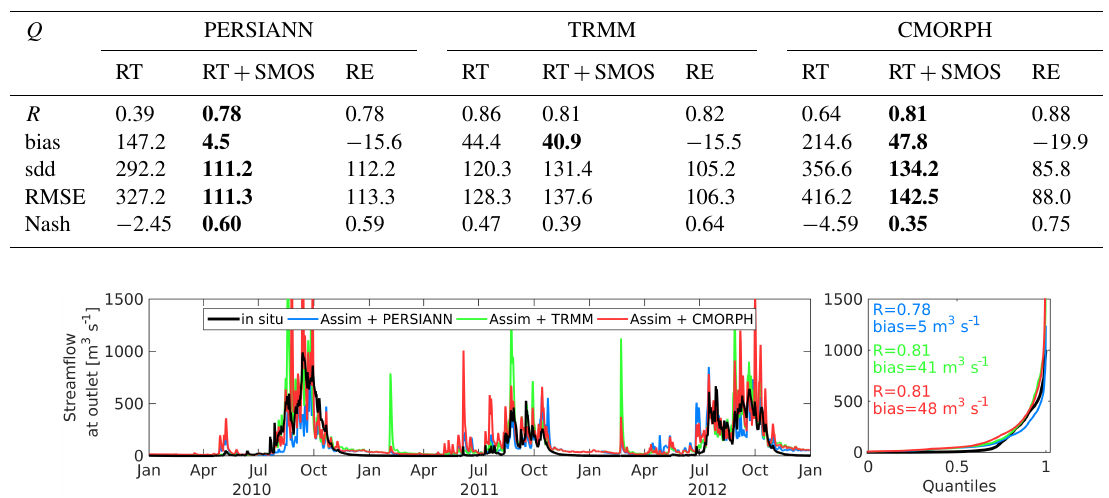
Table 4. Statistics of the simulated streamflow ( Q ) compared to the in situ measurements at the outlet of the basin for 2010–2012. Three cases are considered: open-loop simulations using real-time satellite precipitation (RT), assimilation of SMOS soil moisture with real-time precipitation (RT + SMOS) and open-loop simulation using reanalyzed precipitation (RE). Improvements are indicated in bold font.